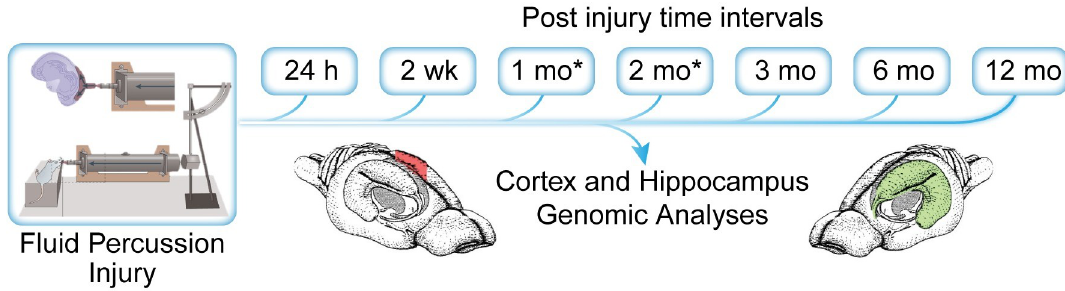
Fig 1. Schematic of experimental design. Rats were subjected to fluid percussion injury (FPI) and survived for 24 hours, 2 weeks, 3 month, 6 month, and 12 months. At the time of sacrifice, whole hippocampal and cortex tissue (beneath the injury site) were manually dissected and stored in RNALater at 4˚ C until processed for genomic analysis. ( � 1 and 2 month time points were subsequently added to the experimental design after the initial analysis was completed for animals survived up to 1 year post-FPI).